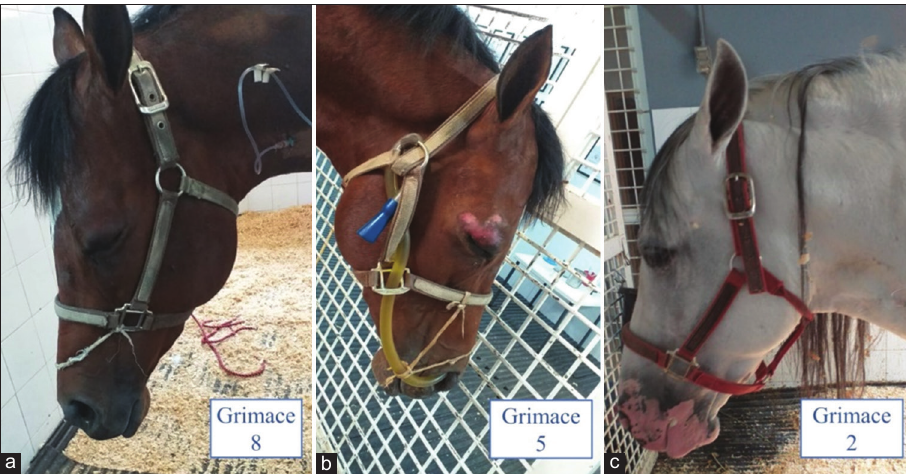
Figure-3: Clinical follow-up of pain based on the horse grimace scale in horses with different degrees of pain. (a) Acute pain severe; it is possible to observe dilation in nostrils, tension in the muzzle and chewing muscles, moreover, an asymmetric position in ears (flattener ears) in a male horse diagnostic with colic. (b) Acute pain moderate; it shows a horse male with colic with treatment for 6 h, where it is possible to see facial movements such as asymmetric/low and accompanied by angled eyes, a tense withdrawn gaze and note the clinical evolution in the position of the ears in comparison with a. (c) 24 h post-treatment. At first, they were, square flaring of the nostrils and tension in the muzzle and chewing muscles. At 24 h post-treatment, however, these scores had decreased. This evidence shows the utility of facial expressions for evaluating analgesic